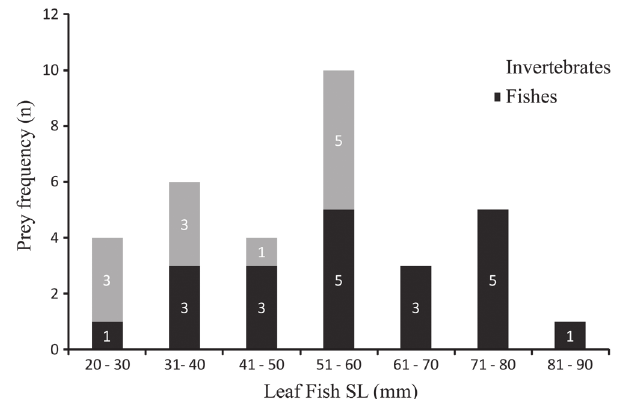
Fig. 2. Proportion of preys (fish and invertebrates) recorded in the stomach of the leaf fish Monocirrhus polyacanthus , by predator size classes (Number of stomachs with food = 19).